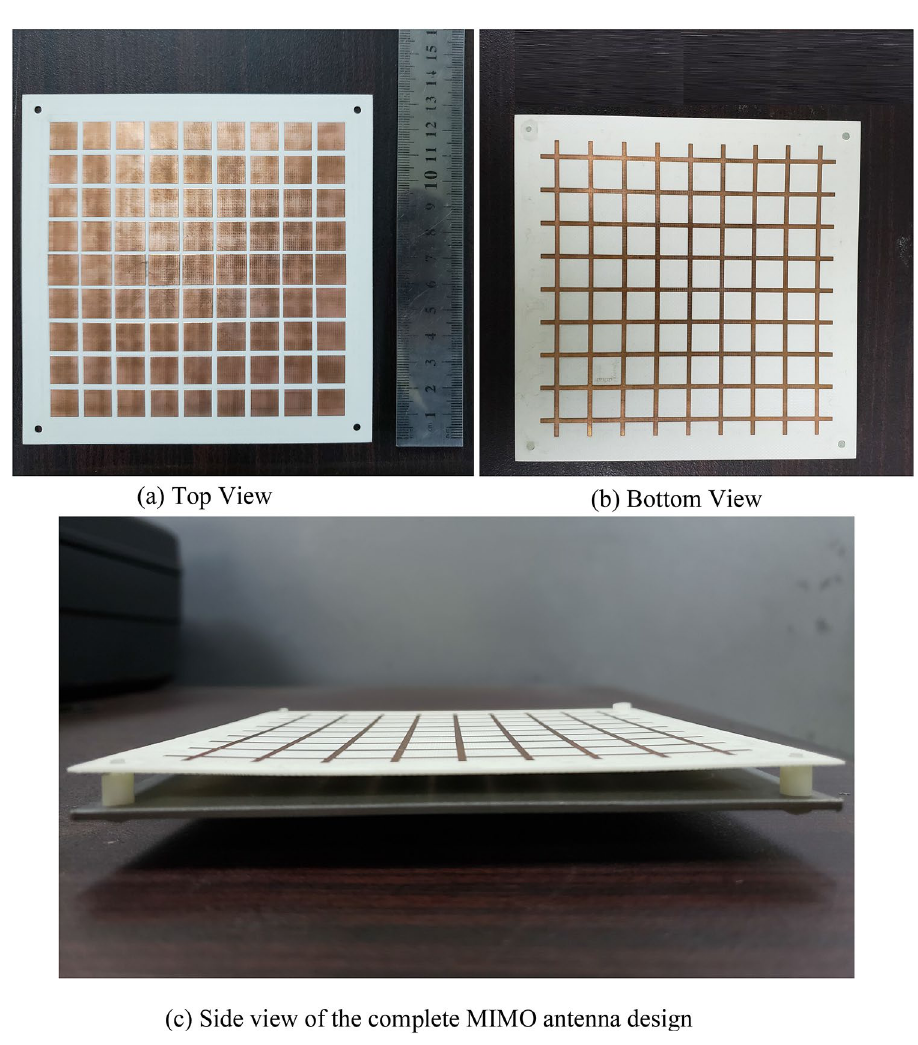
Figure 8. Fabricated